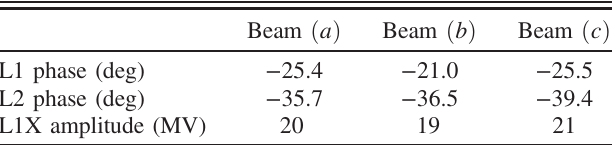
TABLE II. The beam line parameters for the three typical phase spaces in Fig.